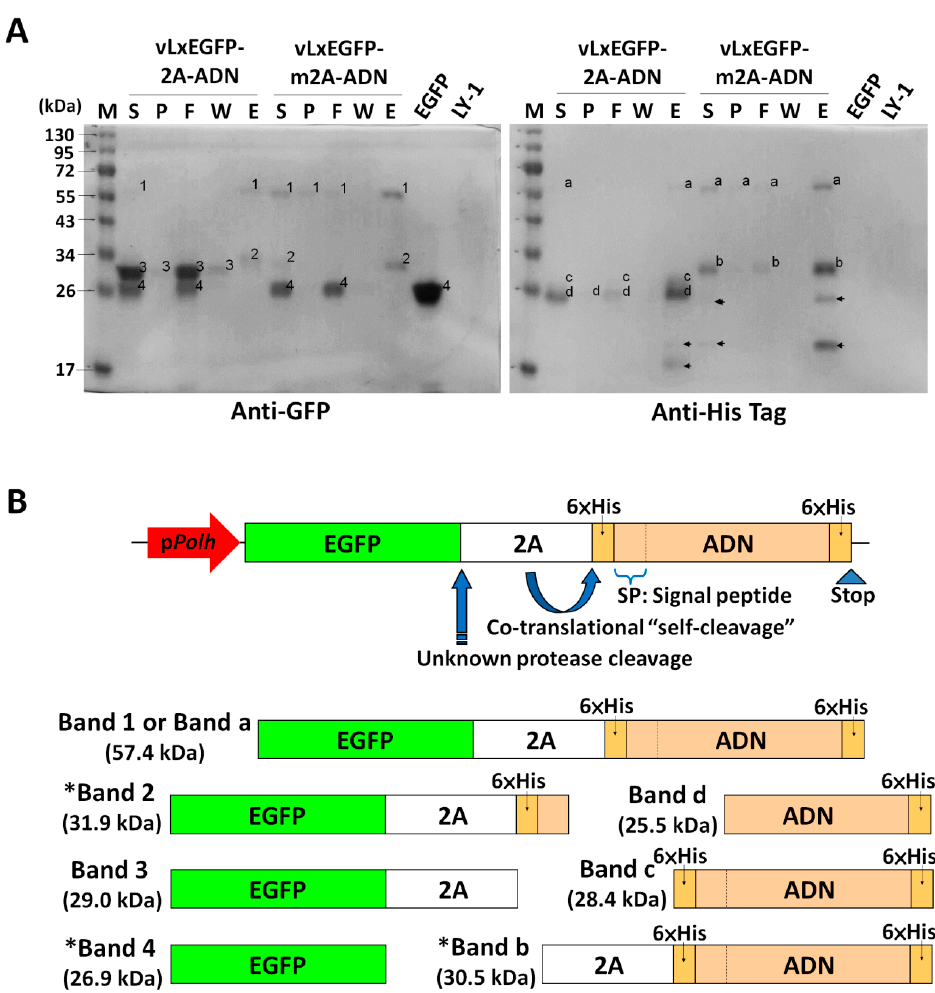
Figure 4. Purification of recombinant proteins and verification of 2A peptide function in NTU-LY cells. ( A ) Western blot analysis of each fraction from the IMAC purification process with anti-GFP (Clontech) and anti-His tagged protein antibodies (Bioman Scientific Co., LTD). Samples obtained from cell cultures infected with the recombinant virus, vLxEGFP-2A-ADN or vLxEGFP-m2A-ADN are indicated above lanes. Protein bands corresponding to bands 1, 2, 3, 4 and bands a, b, c, d (see below) are indicated. Several low-molecular bands that supposedly resulted from protein degradation are indicated by arrowheads. ( B ) Diagram of proposed modifications during or after the recombinant protein EGFP-2A-ADN synthesis. In addition to co-translational “self-cleavage” of functional 2A peptide and signal peptide removal, an unknown protease cleavage was proposed between EGFP and the 2A peptide in the modification process. Bands 1, 2, 3, 4 and bands a, b, c, d were subsequently generated. The molecular weights of these bands shown in parentheses were calculated according to their amino acid sequences. Based on the design, the expected products should be band 1 or band a, band 3, band c, and band d, while band 2, band 4, and band b are putative products (indicated by *). EGFP = proteins obtained from NTU-LY cells infected with a recombinant virus expressing EGFP; LY-1 = proteins obtained from NTU-LY cells; M = protein marker; S = supernatant; P = pellet; F = fraction sample; W = sample from washed solution; E = eluted sample.